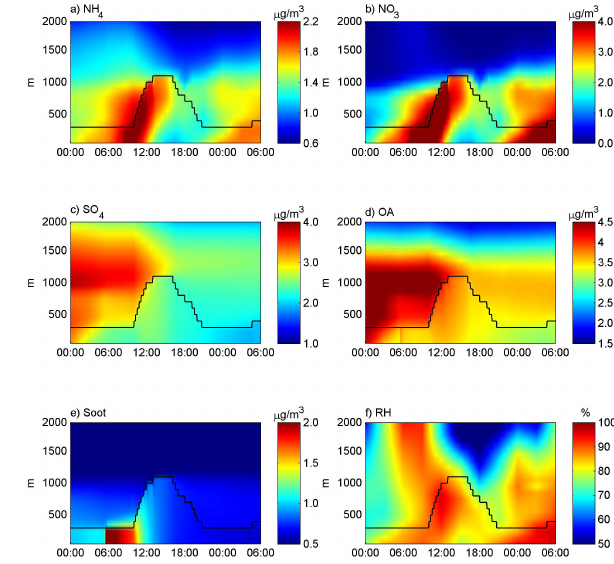
Fig. 9. Modeled size resolved particle mass fractions and pH in each size bin, starting 6h upwind of Malm¨o (00:00) and ending 24h downwind of Malm¨o, (a) for ammonium, (b) nitrate, (c) sulfate, (d) organic aerosol, (e) soot and (f) pH.